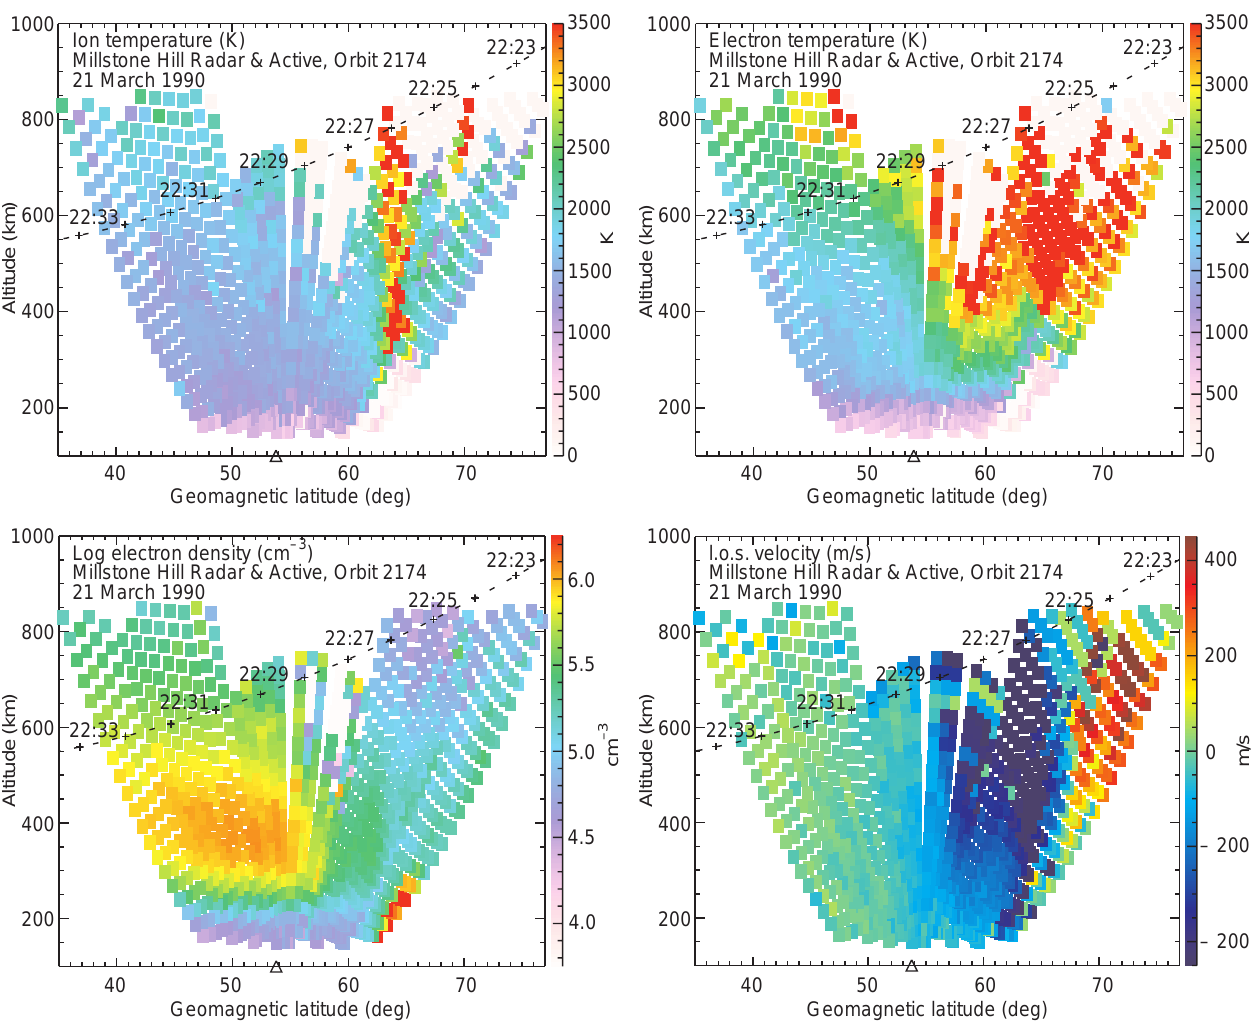
Fig. 5 a–d. The same pass of the Active satellite as in Fig. 4, but as altitude versus geomagnetic latitude colour-coded plots showing the simultaneously measured Millstone Hill radar data of the: a ion and b electron temperatures, c electron density and d the line-of-sight